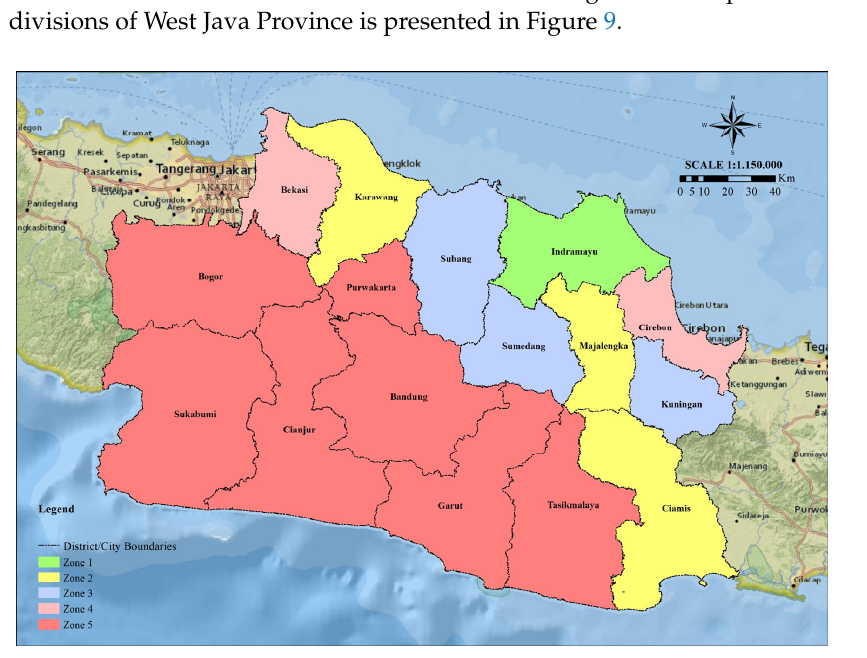
lunggung Mountain in Garut, and the Salak and Gede Mountains at Bogor. 4.3.3. Clustering Type II The clustering of type II uses the EDRI category and the K-Medoids algorithm for dividing area W. The K-medoids algorithm can reduce the sensitivity of the grouping re- sults due to the presence of data outliers, which are checked using a boxplot. The first stage for making a boxplot is to scale the data for the earthquake magnitude, the earth- quake depth, and the distance between earthquake events, and we used the Rstudio ap- plication to make Figure 10.